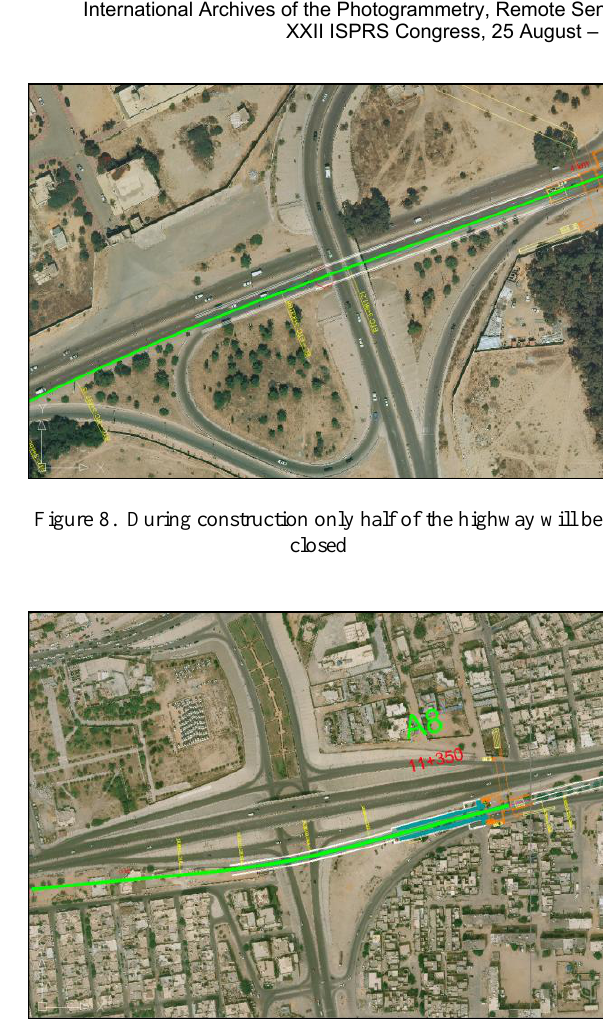
Design criteria taken into consideration during different planning stages were the following: The design speed is 80 km/h. Metro lines were designed with minimum curve radius of 550 m and transient curve of P = 110 m (A